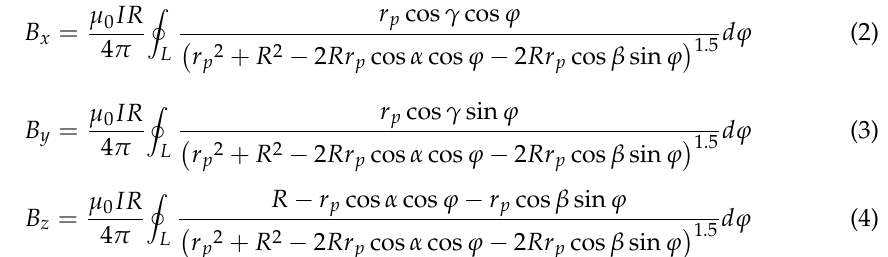
→ → l and r can be substituted into Equation (1).